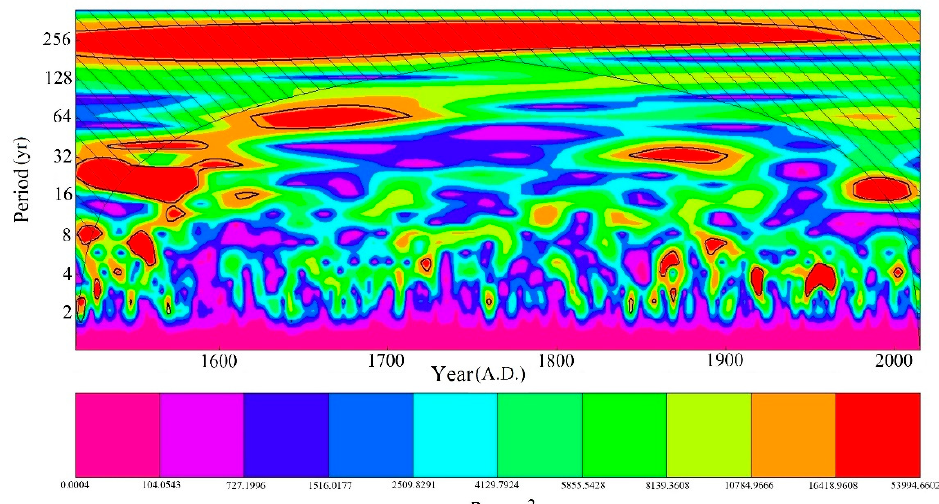
Figure 7. Wavelet analysis of the spring precipitation reconstruction py AMJ + AMJ from 1515 to 2015. Detected periodicities highlighted by black outline are significant at the 95% confidence level.